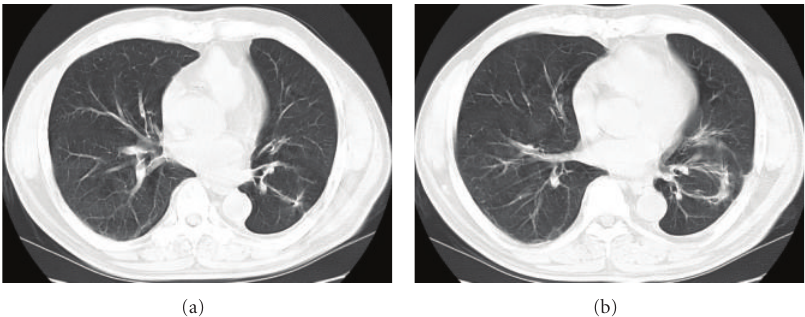
Figure 7: Twelve months after the first operation. All metastatic lesions were eliminated through the chemotherapy and thoracic